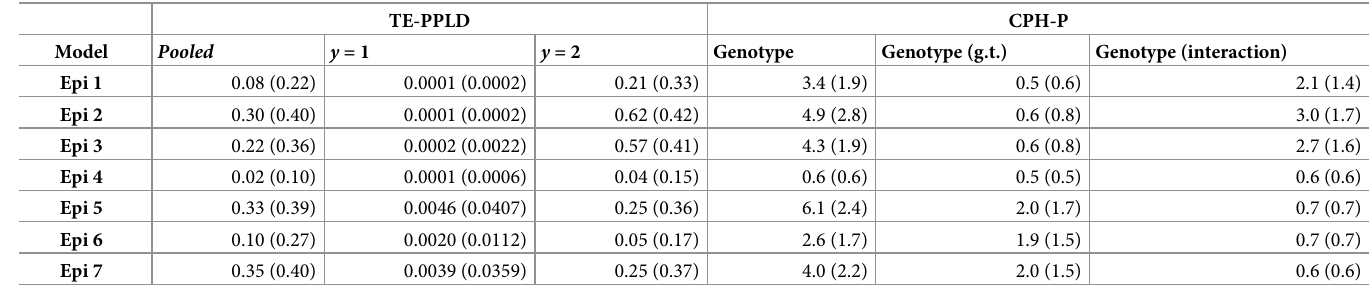
Table 8. TE-PPLD and CPH-P results under epistasis models Epi 1 –Epi 7 from Table